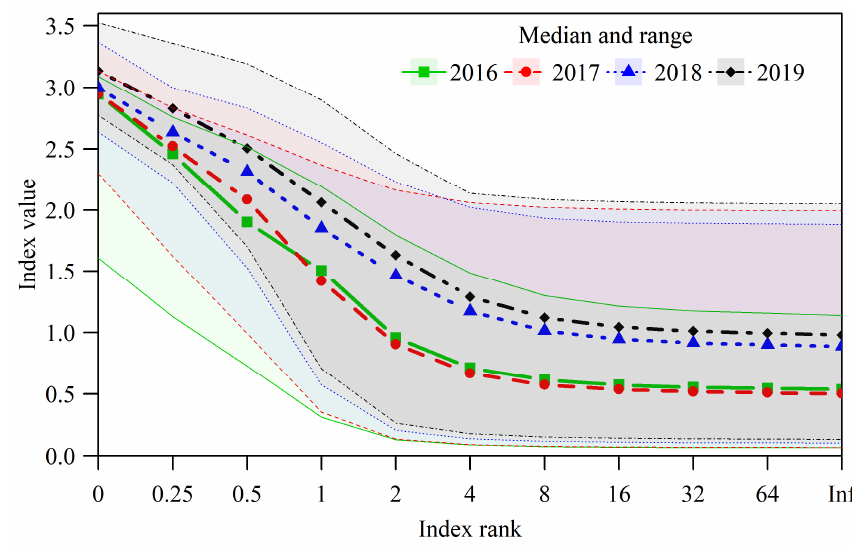
Figure 4. Rényi diversity profiles (Hα) for patches in the successive years of the study.